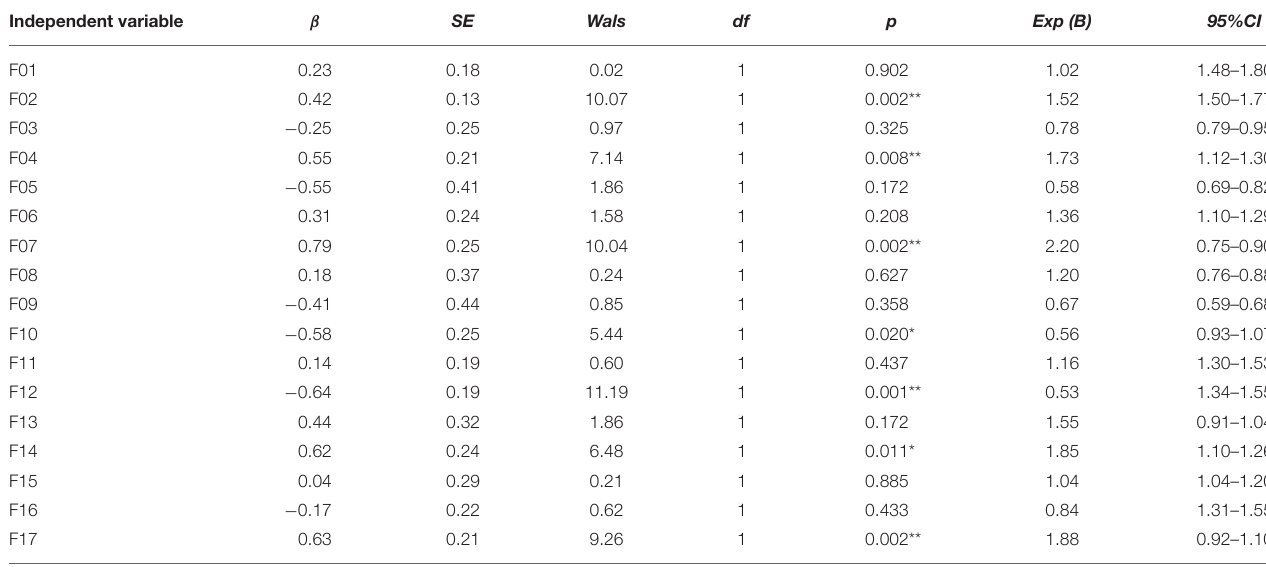
TABLE 3 | Results of the logistic regression model of facial muscle activity intensity in the schizophrenia group and the healthy control group. Independent variable